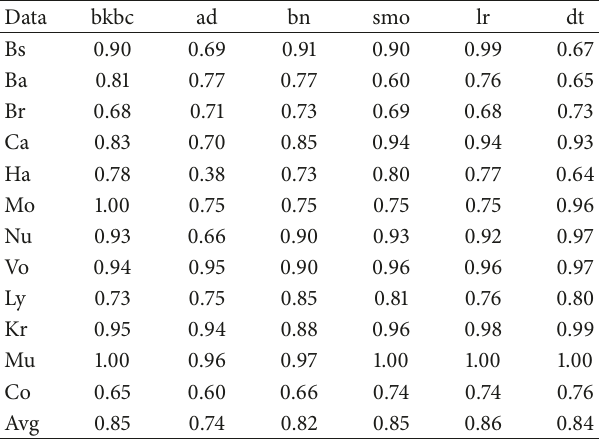
Table 13: Performance comparison on single dataset. Data